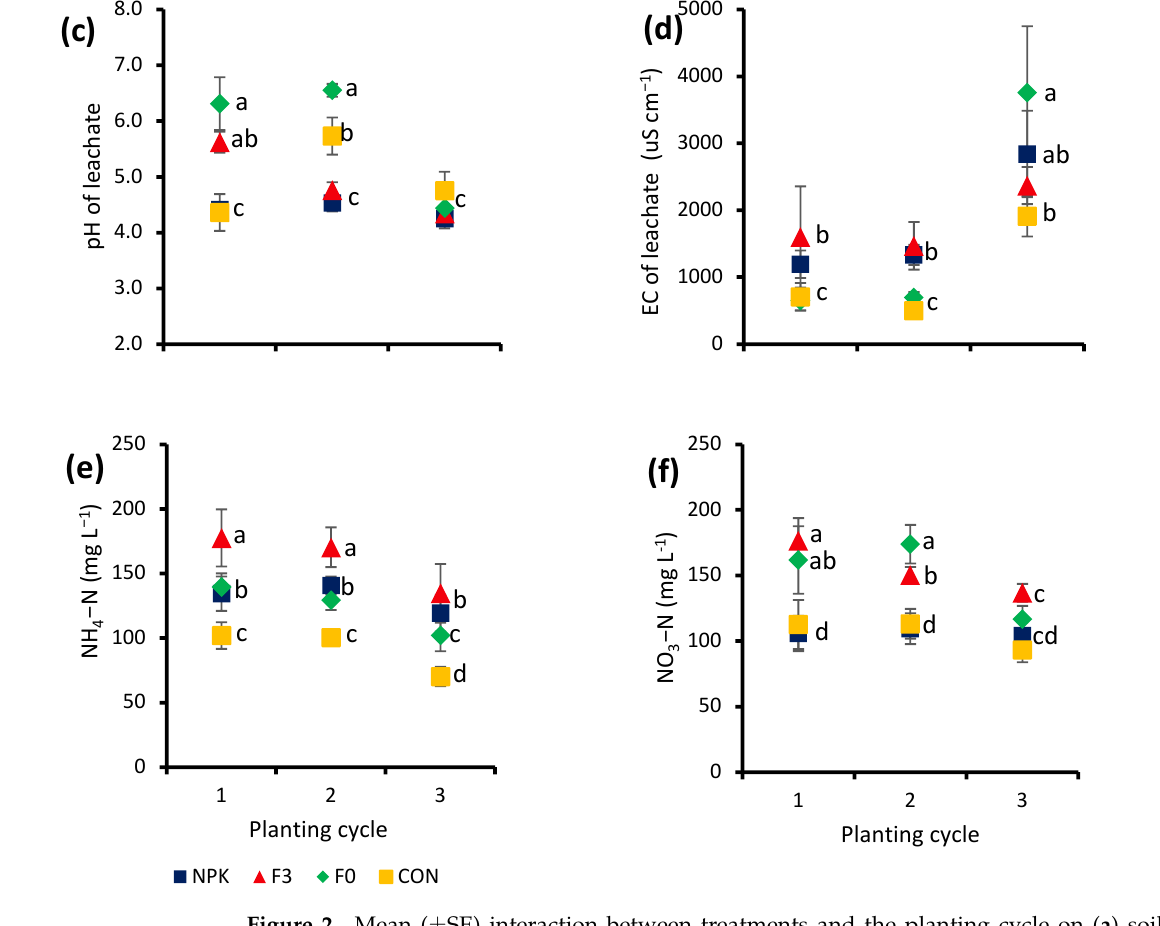
Figure 2. Mean ( ± SE) interaction between treatments and the planting cycle on ( a ) soil VMC, ( b ) leaching volume, ( c ) pH, ( d ) EC, ( e ) NH + , and ( f ) NO − contents of leachate. On the same chart, means with the same letters are not significantly different ( p > 0.05) from one another using Tukey’s test. VMC is volumetric moisture content. Table 5. Means ( ± SE) of interaction effect between soil types and treatments on volumetric moisture content and leachate nutrient contents. Soil Type Treatment